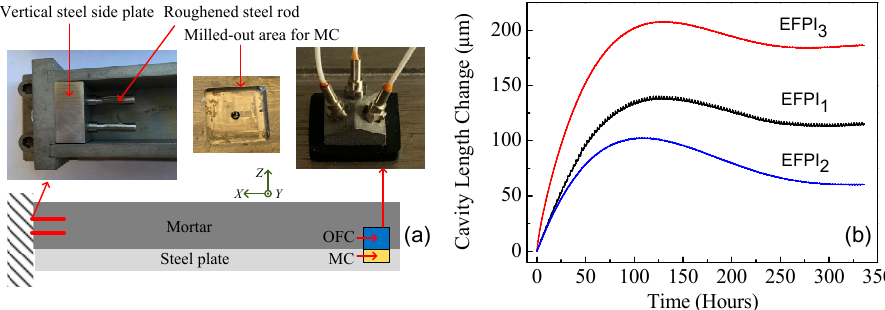
Figure 6. Continuous displacement measurements. ( a ) The schematic diagram of the experiment setup for monitoring delamination and sliding. Note that the mirror component (MC) is embedded in a milled-out square area that is 3 mm deep so that the top surface of the metal base support of the MC matches the top surface of the steel plate. ( b ) Cavity length changes as a function of time from three EFPIs during continuous displacement measurements for a brick of mortar during the drying/curing process. OFC and MC represent the optical fiber component and the mirror component, respectively. Mortar components and weight ratios: Sakrete Portland Type-1 cement, 1.0; tap water, 0.5; sand, 2.8. Brick of mortar size: 254.0 mm × 25.4 mm × 25.4 mm.